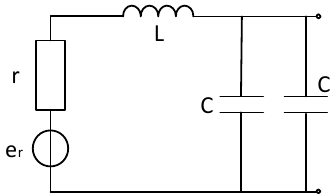
Figure 10. Noise distribution with matched capacitive sensor.